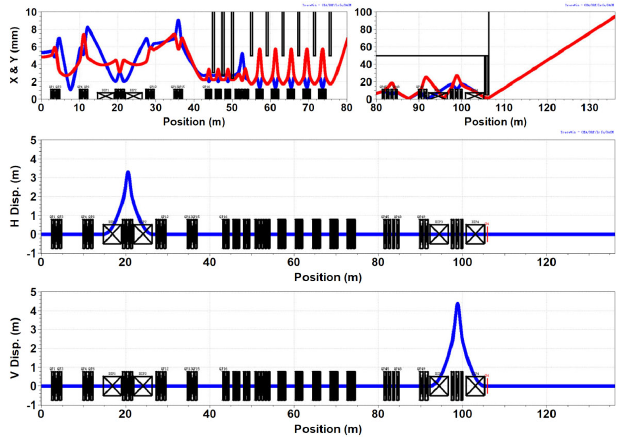
FIG. 3. 5 σ envelope and dispersion function at CiADS A2T section. (The maximum dispersion function is about D ¼ 4 . 4 and D y